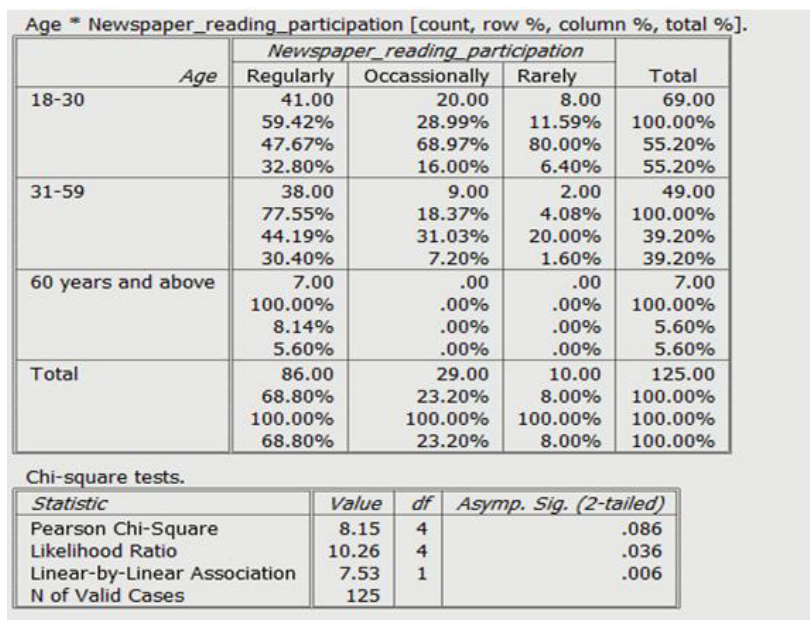
Figure 3: Cross Tabulation and Chi-square between Gender v/s Type of News (Source: Authors‟ depiction) According to this Chi-square test p-value ≤ 0.05, we can say gender has no significant effect on the type of news read.